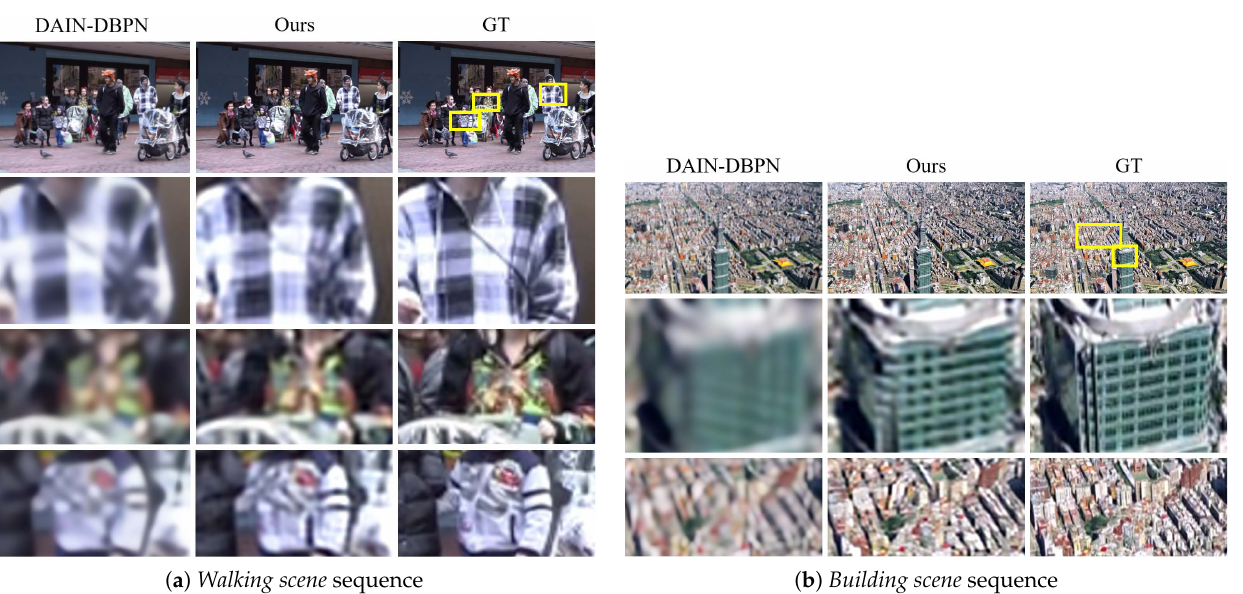
Figure 2. Comparison on the ( a ) Vid4 dataset and the ( b ) SPMCS dataset. Our method shows favorable preservation of ( a ) the pattern and textures on clothes, and ( b ) the pattern and textures on a building. The magnified regions are denoted as yellow boxes.